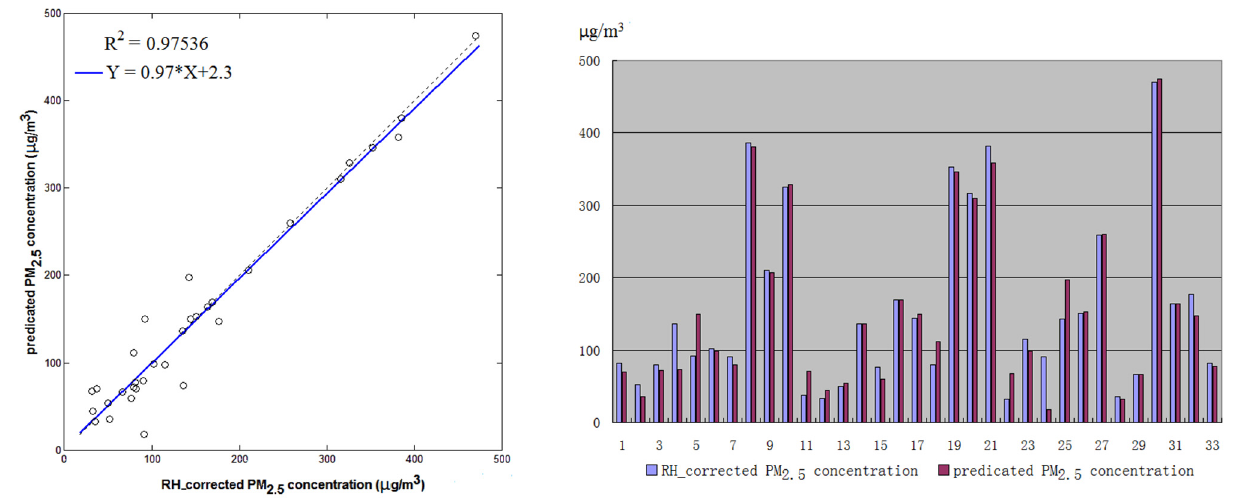
Figure 5. Correlation of the relative humidity corrected (RH_corrected) PM 2.5 concentrations and the PM 2.5 concentrations predicated by the BP